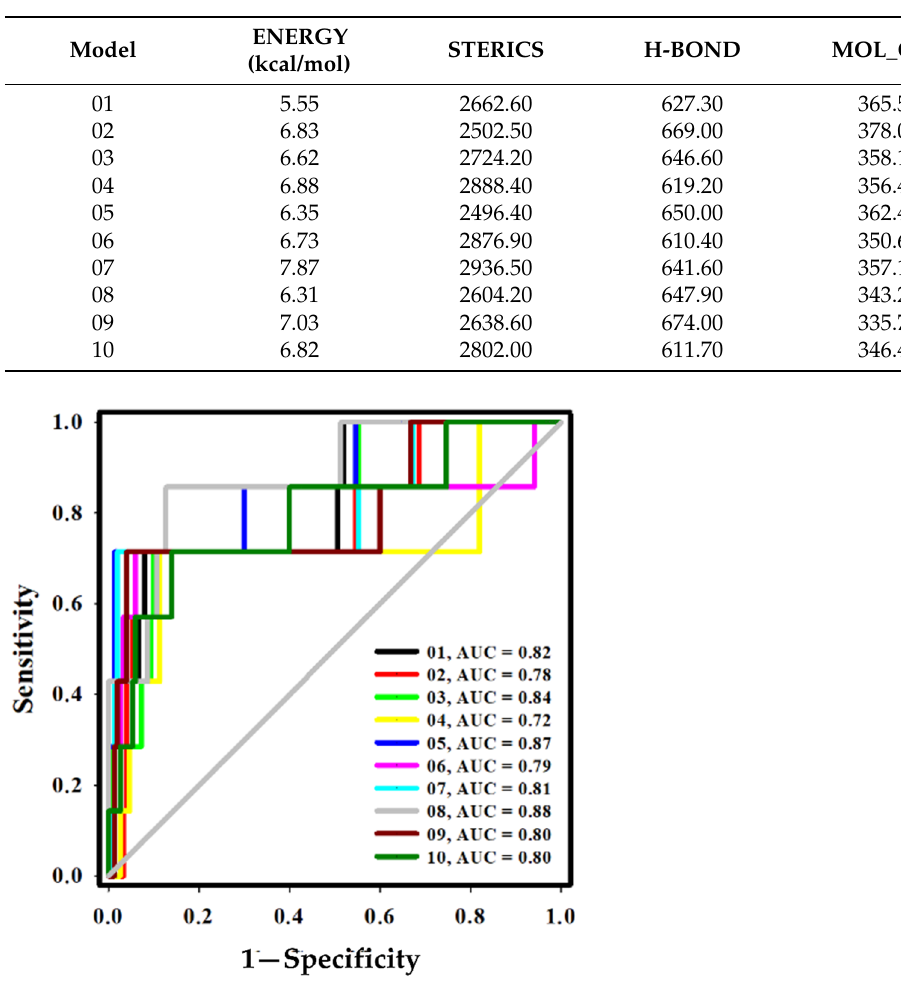
Table 1. Internal statistical parameters for pharmacophore models provided by GALAHAD™.